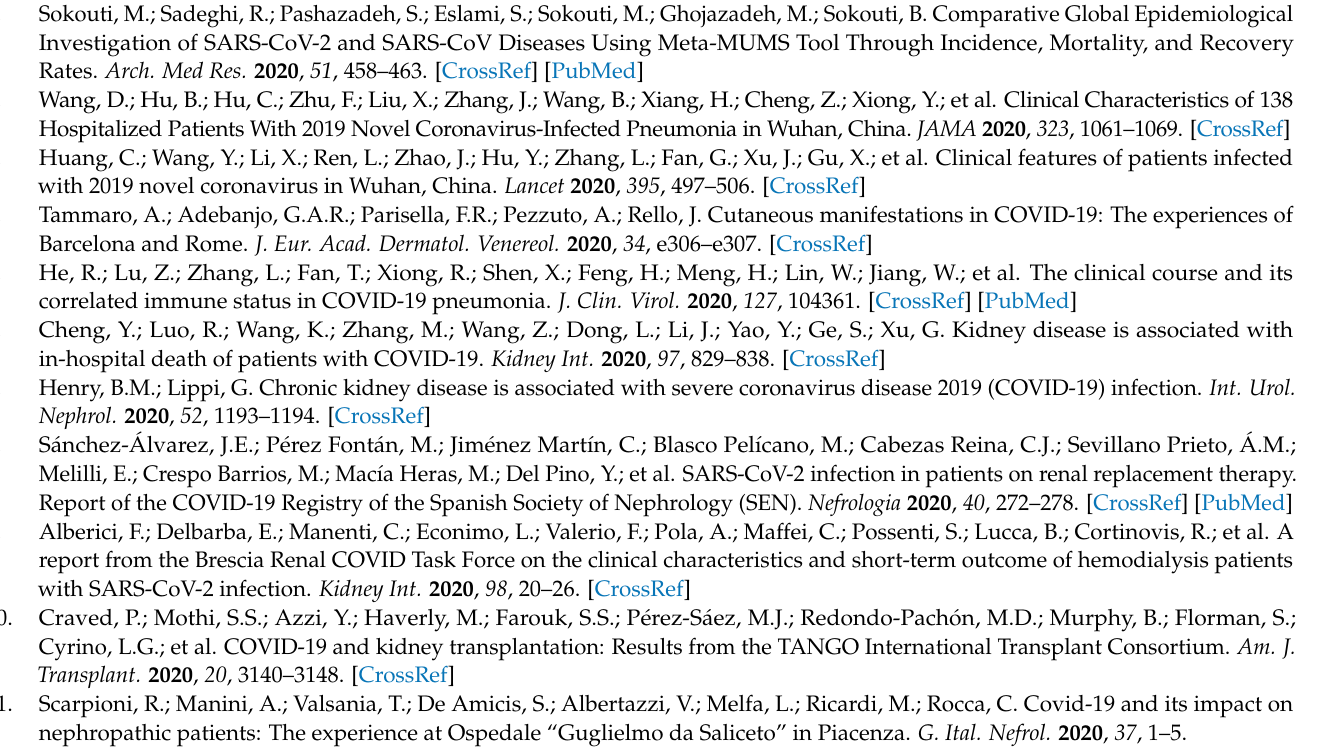
The numbers reported are based on the sensibility and specificity reported by Wang et al [29]. PPV = 19/311 = 6.1% -> means when my test is positive the likelihood to have a COVID-19 patient is 6.1%. NPV = 1636/1689 = 96.9% -> means when my test is negative the likelihood to have a NO COVID-19 patient is 96.9%. The previous tables are extracted from a study published, which reported sensitivity and specificity of saliva and oropharyngeal swab considering as reference nasopharyngeal swab, but unfortunately the real sensitivity and specificity of nasopharyngeal swabs remain